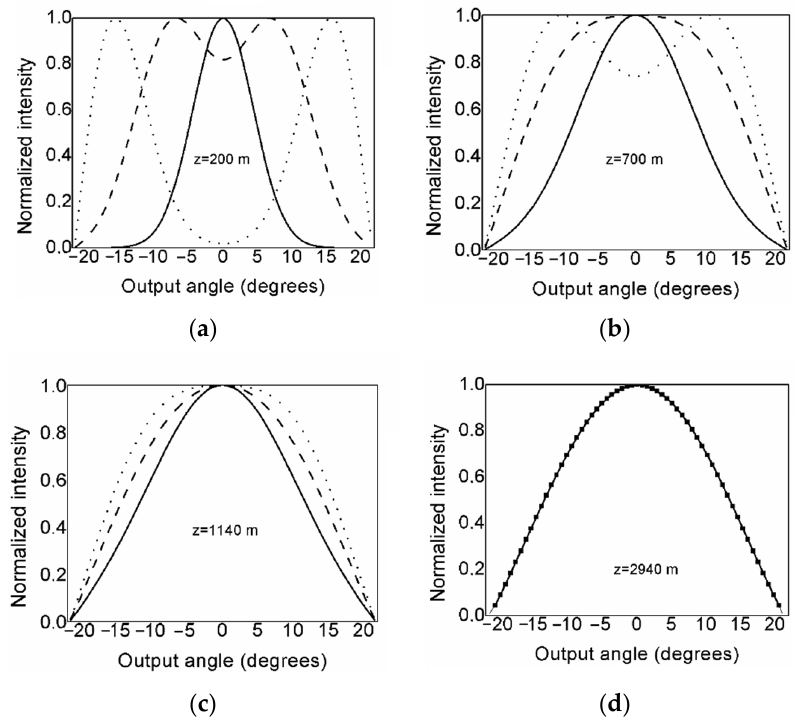
Figure 2. Normalized output angular power distribution at various positions along each of the MC PCSF’s seven carrier cores calculated for Gaussian input angles θ 0 = 0° (solid line), 8° (dashed line) and 16° (dotted line), with (FWHM) z =0 = 10° for: ( a ) z = 200 m; ( b ) z = 700 m; ( c ) z = 1140 m and ( d ) z = 2940 m.